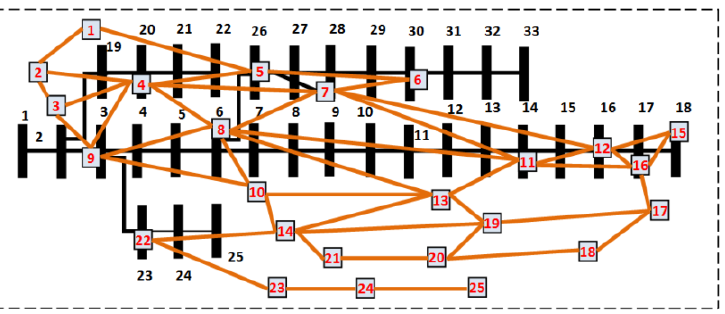
Figure 4. Superimposed network of the IEEE-33 bus system and the 25-node road network [5,58].